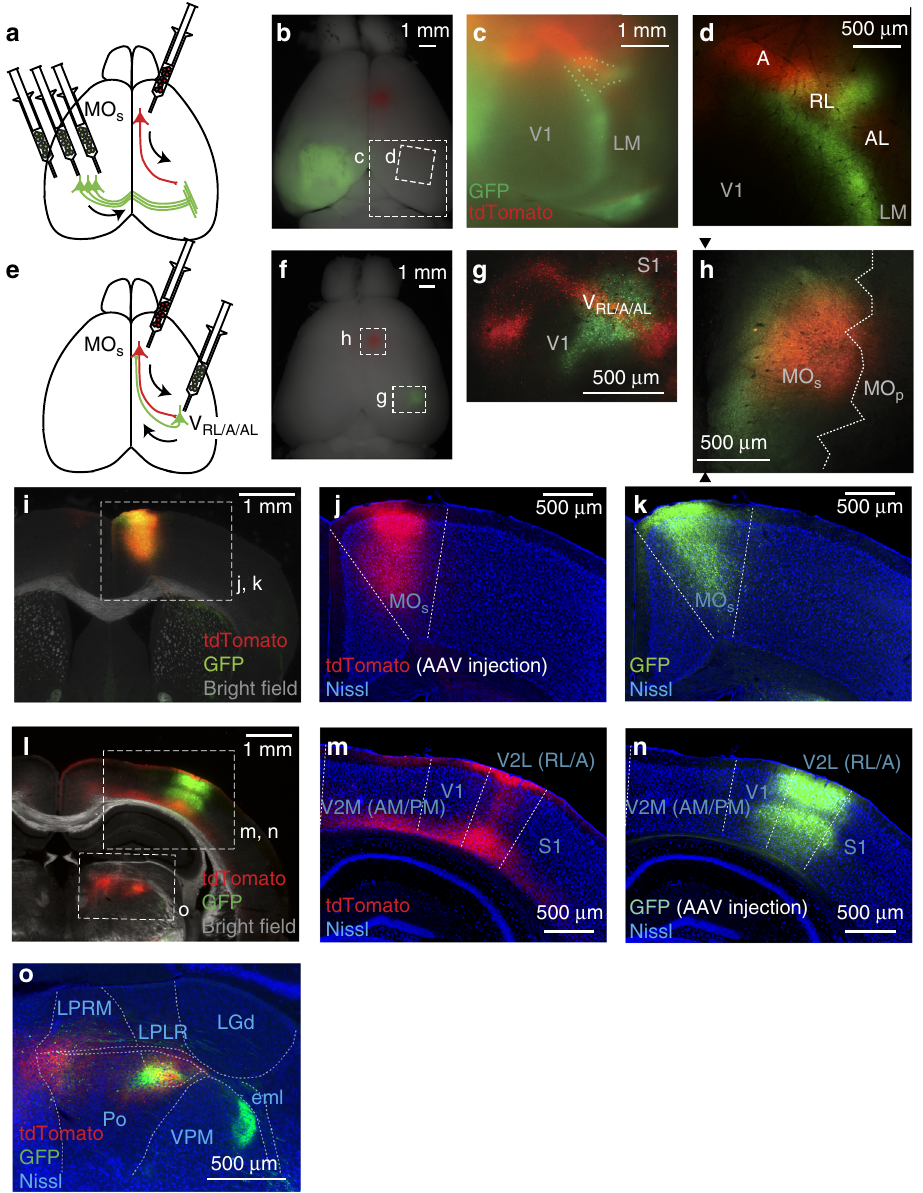
Fig. 4 Reciprocal connectivity between MO s and V RL/A/AL . a – d Connectivity from the MO s to the V RL/A/AL . a The experimental design for the dual-virus injections. AAV-tdTomato was injected into the MO s in the right hemisphere and AAV-GFP was injected into the occipital regions in the left hemisphere. b A corresponding whole-brain image. c , d The tdTomato projection from MO s overlapped with areas RL, A, and AL (V RL/A/AL ). GFP-labeled callosal projections delineated boundaries between the V1 and higher visual areas. The image c was taken with a fl uorescent stereoscopic microscope from the dotted rectangle in b , and the image d was taken with a two-photon microscope from a region indicated in b . e – n The V RL/A/AL projects back to the MO s . e The experimental design for the sequential virus injections. First, AAV-tdTomato was injected into the MOs, and then a couple weeks later AAV-GFP was injected into the tdTomato-labeled axonal band (the V RL/A/AL ). f A corresponding whole-brain image. g At the injection site of AAV-GFP, the expression overlapped with the tdTomato-labeled axonal band (the location of V RL/A/AL ). h At the injection site of AAV-tdTomato (the MO s ), the expression overlapped with the GFP-labeled axonal band. The two black arrowheads indicate the midline, and the white dotted line is the expected areal border based on coordinates and Paxinos and Franklin ’ s atlas. i – k A coronal section that includes the MO s . The injection site for AAV-tdTomato at MO s ( j , tdTomato) and the axon terminals from the V RL/A/AL ( k , GFP) overlapped well. l – n A coronal section that includes V RL/A/AL . The axon terminals originating from the MO s ( m , tdTomato) and the inection site for AAV-GFP ( n , GFP) overlapped well. The dashed lines in j , k , m , and n indicate the areal borders based on Nissl staining. o Projections from the MO s and the V RL/A/AL in thalamus. Note that projections from the V RL/A/AL to the higher visual thalamus (LPLR) 73 overlapped with those from the MO s . The borders were drawn based on descriptions in refs. 42,